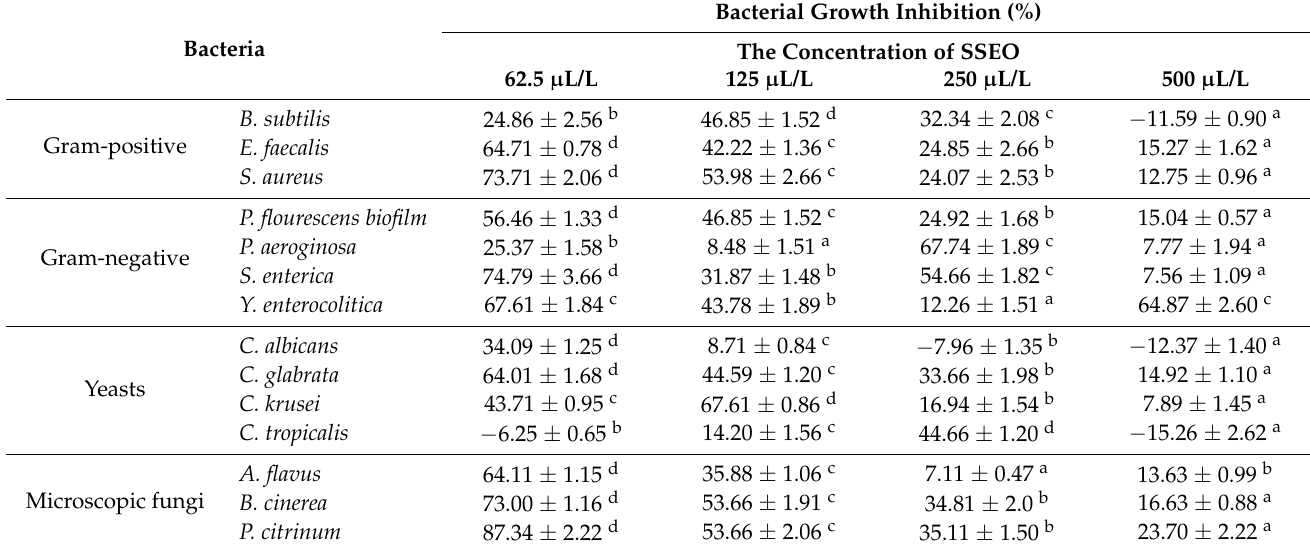
Table 7. In situ analysis of the antimicrobial activity of the vapor phase of SSEO in